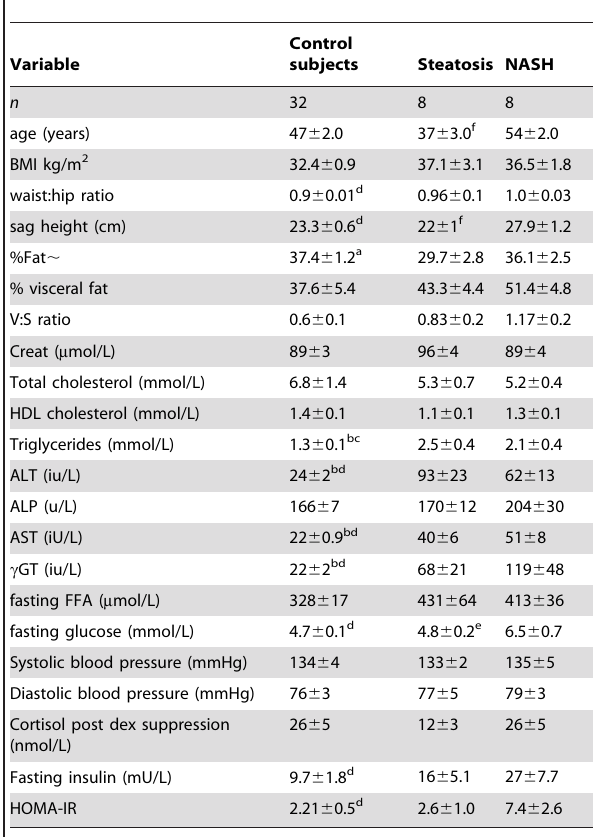
Table 1. Baseline clinical characteristics of patients with hepatic steatosis, NASH and